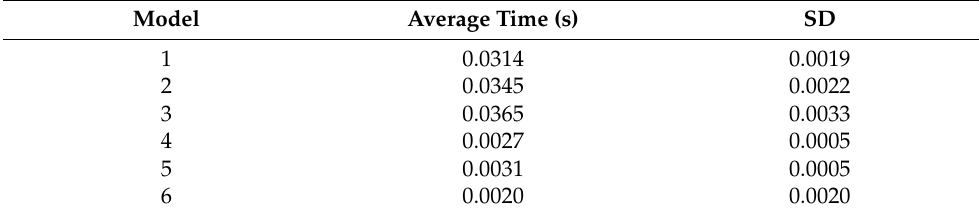
Table 2. Total performance index. Table 3. Average processing speed time of six